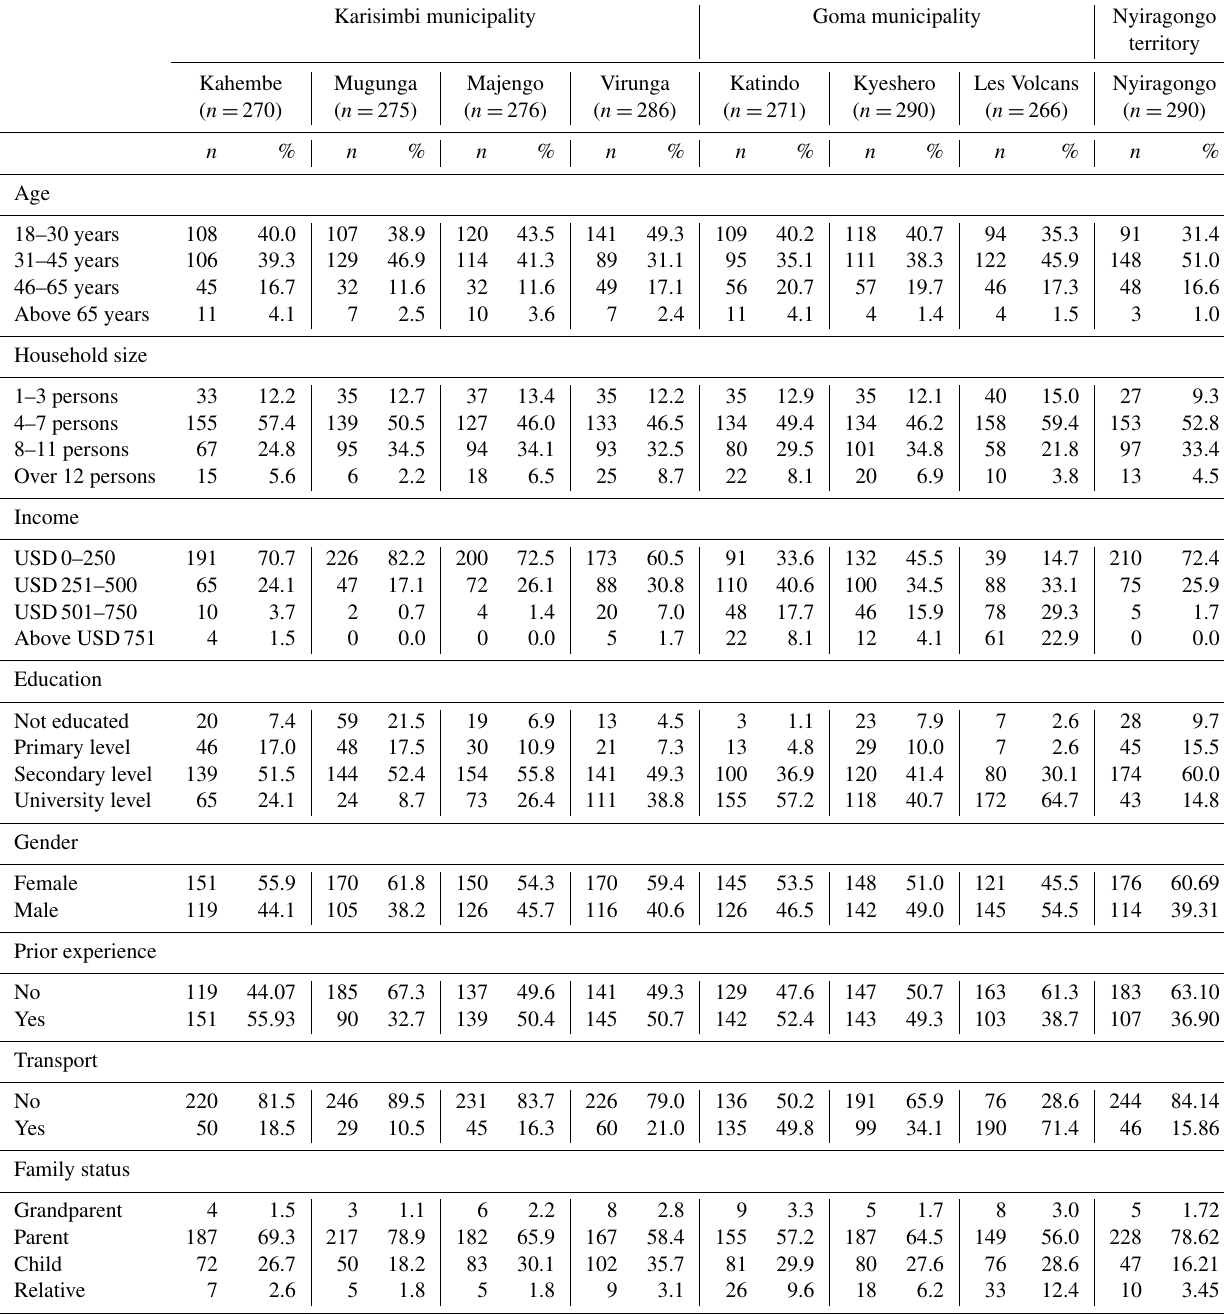
Table A1. Detailed overview of the participant demographic characteristics across